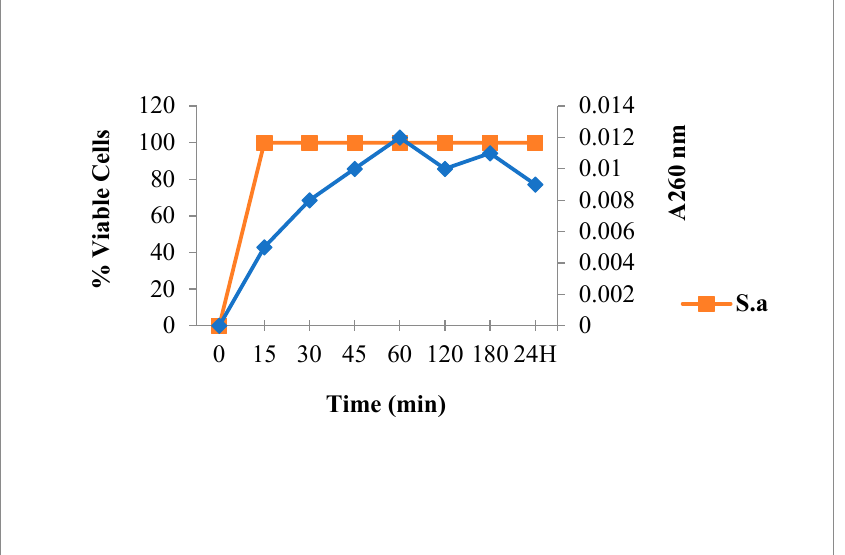
Figure 2. 260 nm absorbent material release and viability of S. aureus in absence of antibacterial agent.